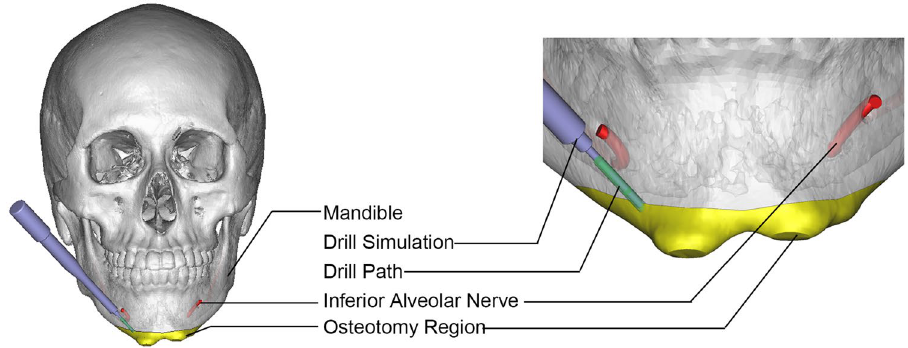
Figure 1. Mandibular deformity treated with